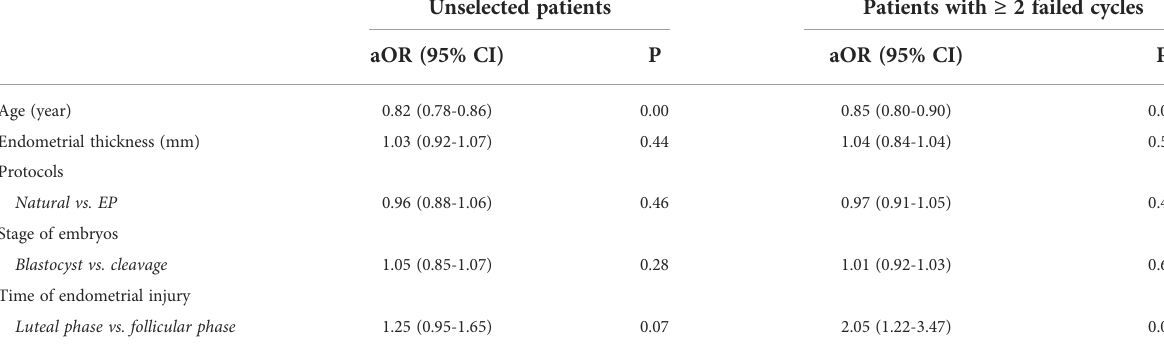
TABLE 3 Factors associated with clinical pregnancy rate in unselected patients and patients with ≥ 2 failed transfer